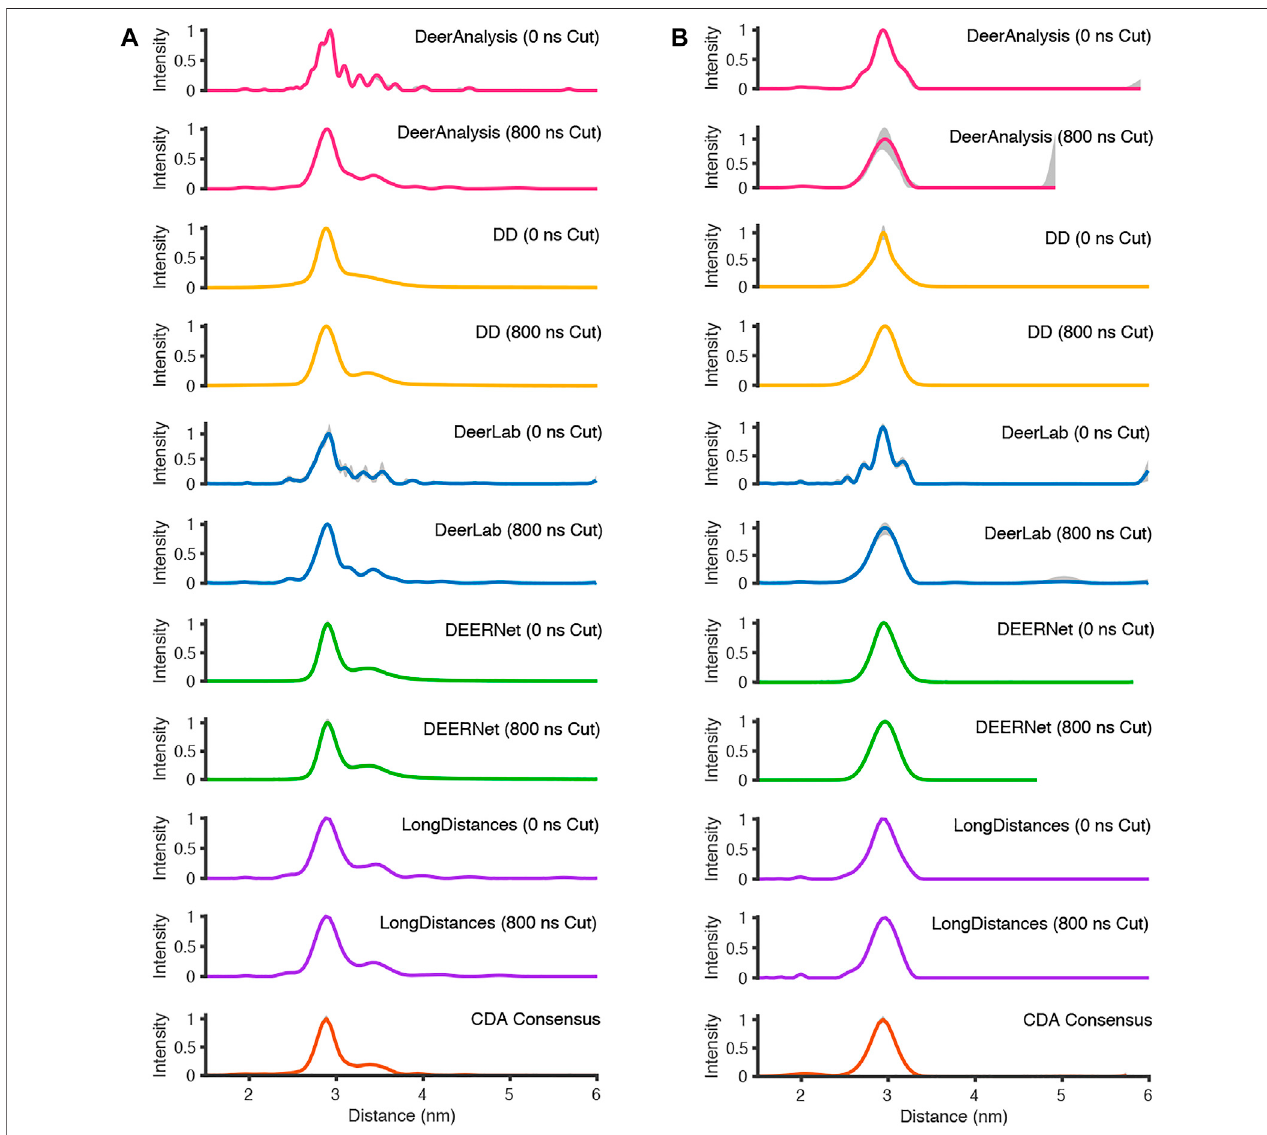
FIGURE 8 | The analysis of the experimental DEER time traces using the various analysis packages (CDA Consensus is the consensus result from ComparativeDeerAnalyzer) (A) AGAO; (B)